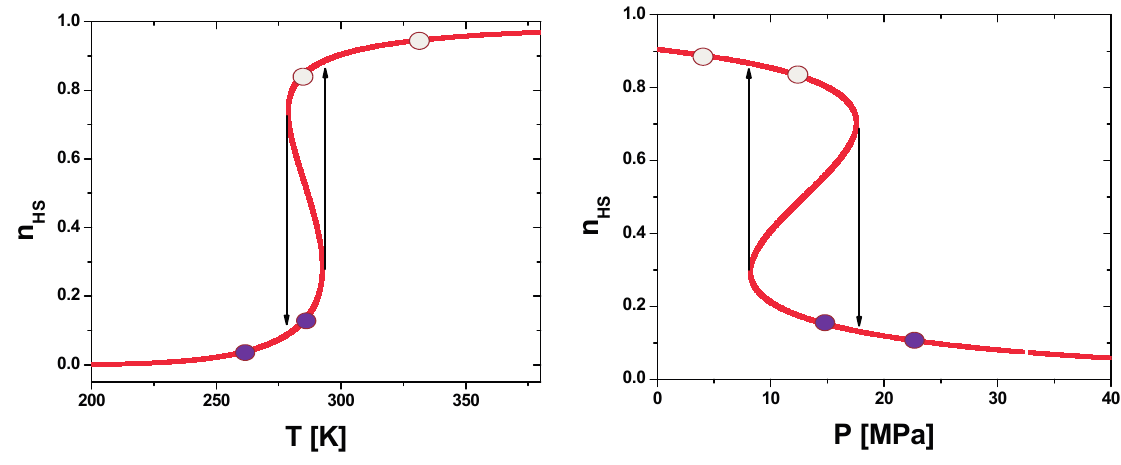
Figure 6. Thermal dependence at 1 bar ( left ) and pressure dependence at 300 K ( right ) of the HS molar fraction, n HS , as derived from the Ising like model. The parameters values are Δ 0 /k B = 1978.6 K, δ V = 100 A 3 , ln g = 6.906 and Γ /k B = 360 K .